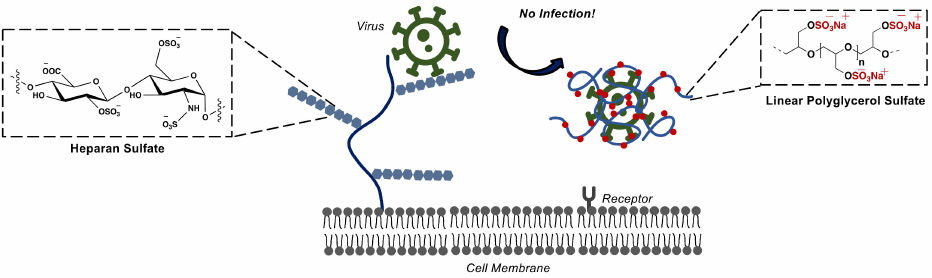
Figure 8. Competitive multivalent binding of a virus to a sulfated linear polyglycerol scaffold instead of heparan sulfate and infection